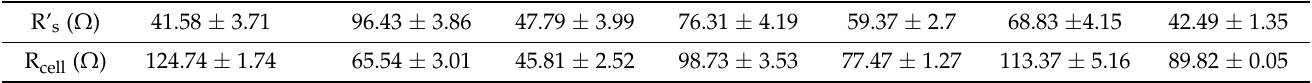
Table 1. Derived R (cid:48) s and R cell of HeLa cells treated dose-dependently with DDP, DOX, and 5-FU. R’ s ( Ω